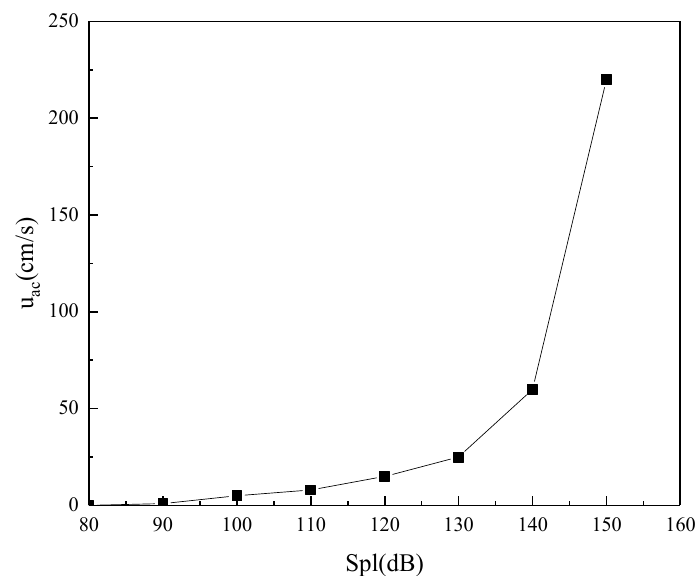
Figure 15. Curve of the relation between the sound velocity and sound pressure.